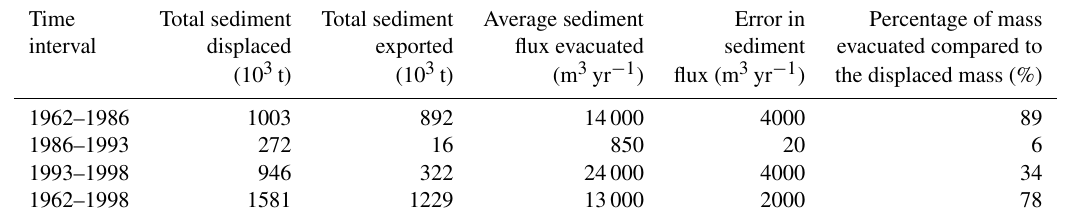
Table 2. Sediment fluxes between 1962 and 1998 (after Schwab et al., 2008).